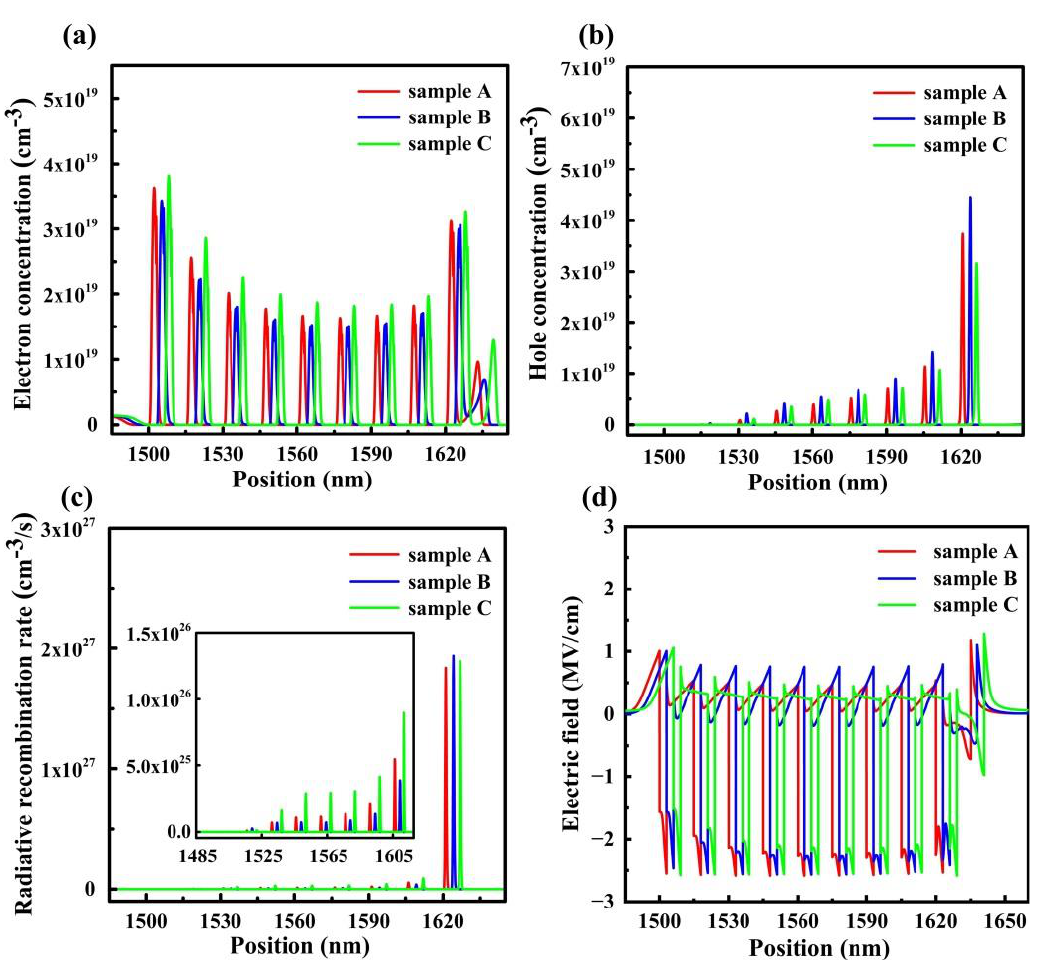
Figure 3. ( a ) Electron and ( b ) hole concentration distribution in MQWs for sample A, sample B and sample C. ( c ) Radiative recombination rate in MQWs for sample A, sample B and sample C. the inset shows the radiative recombination rate in eight QWs except the last QW. ( d ) Electric fields in MQWs for sample A, sample B and sample C. The data are acquired at 60 A/cm 2 . The electron